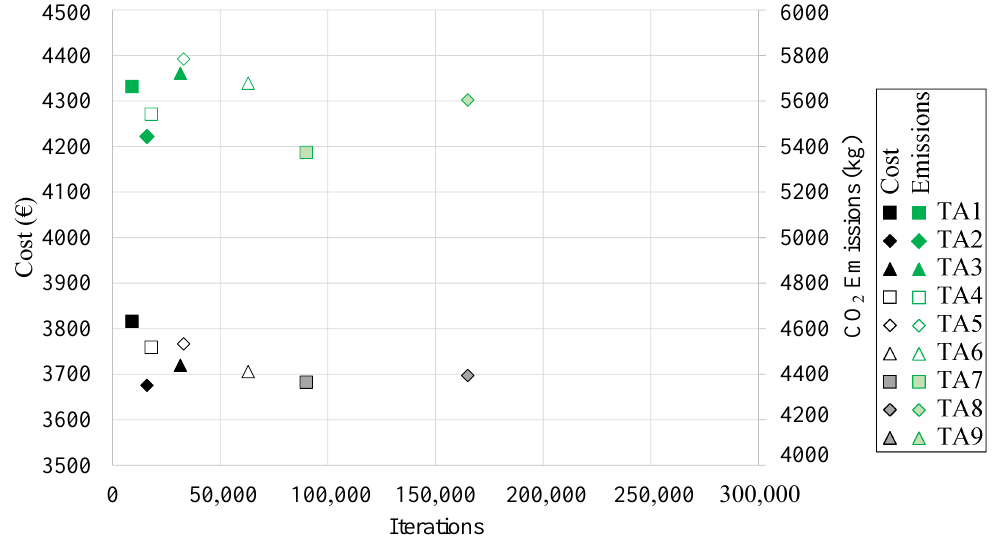
Figure 9. Minimum final cost and associated CO 2 emissions obtained by the TA